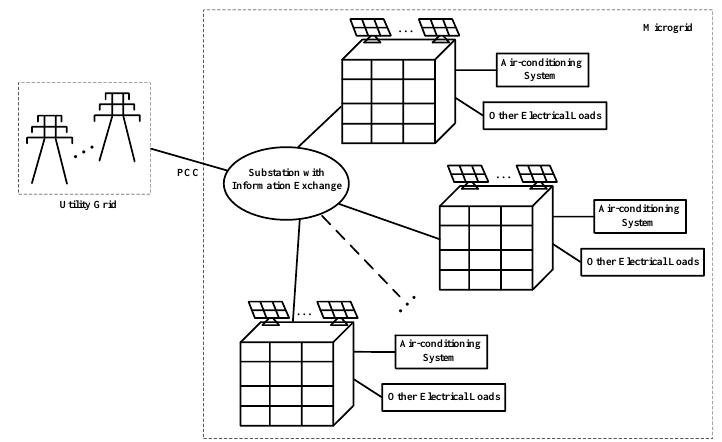
Figure 1. Block diagram of buildings with air-conditioner (AC) and solar generation (SG) in